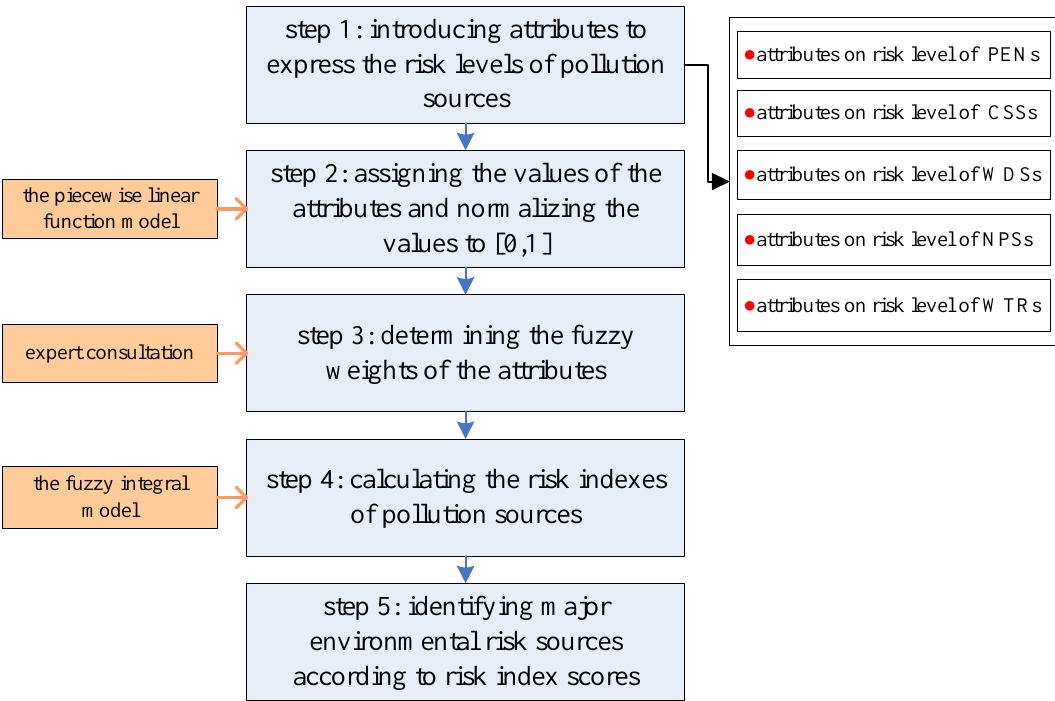
Figure 3. Procedure of major risk source identification by calculating integrated risk